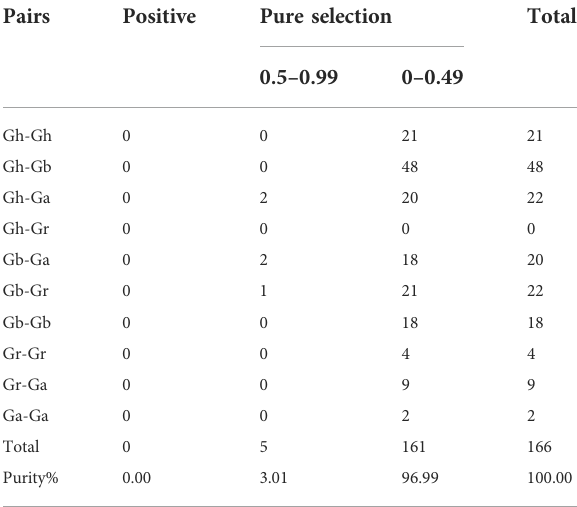
TABLE2Predictionofthenumberofduplicatedgenepairsinvolvedin different combinations from four Gossypium